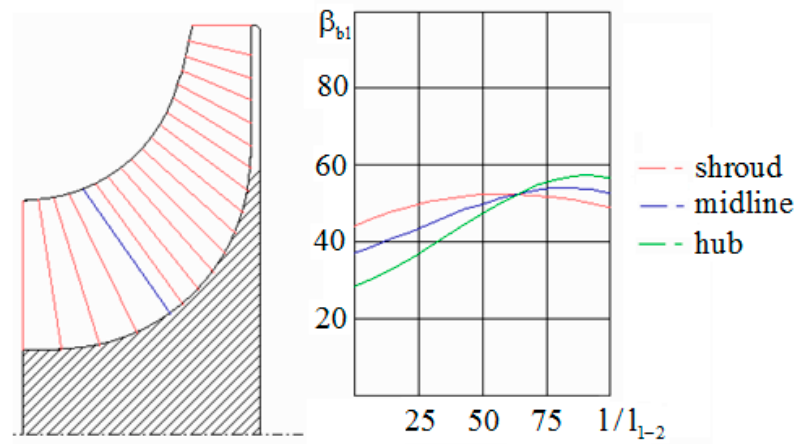
Figure 5. Program 3DM.023. Left: the meridional contour of the impeller. Right: blade angles on three blade-to-blade surfaces.